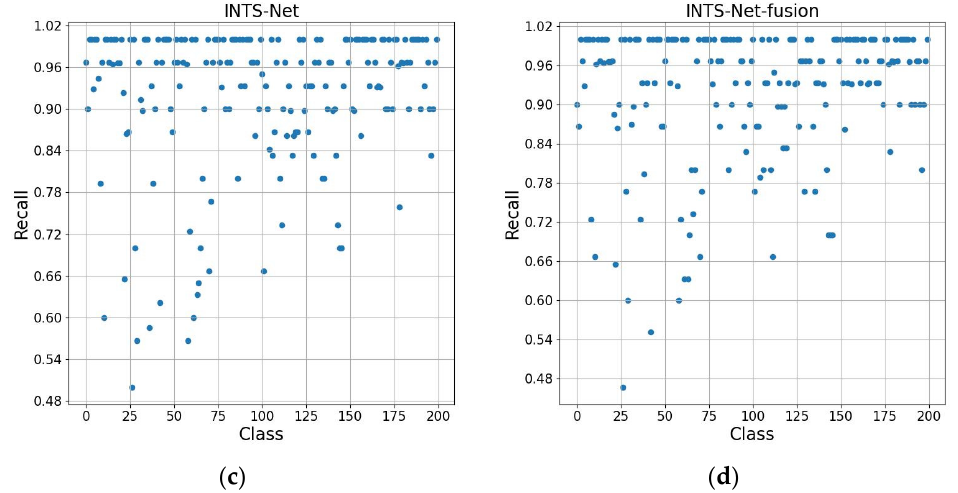
Figure 7. Precision and recall in each category. ( a , c ) are the results before fusing BN and CNN. ( b , d ) are the results after fusing BN and CNN.